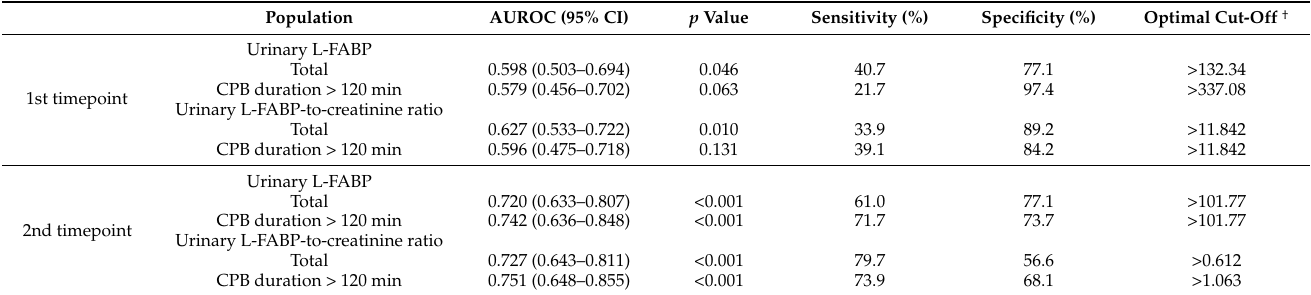
Table 3. Urinary L-FABP and urinary L-FABP-to-creatinine ratio performance in discriminating